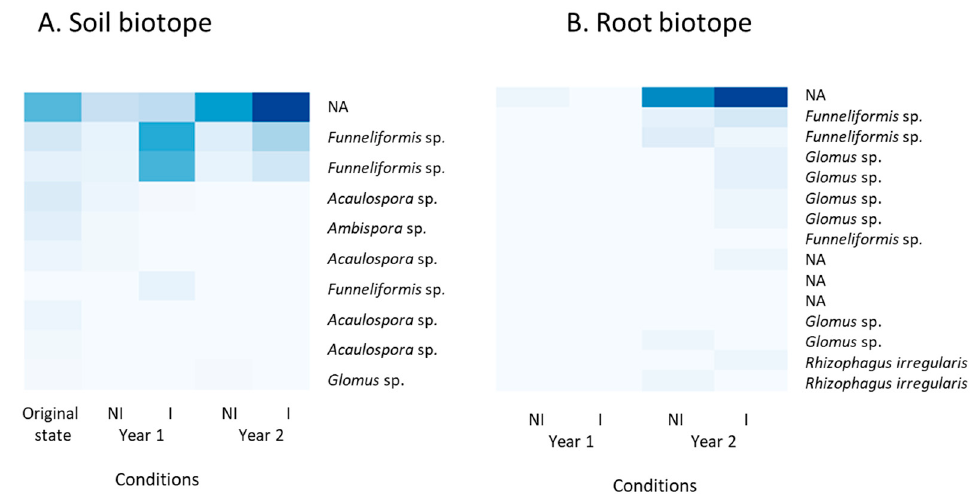
Figure 4. Heatmap representation based on the abundance of the 10 and 15 most-represented ASVs from the 18S rRNA gene data set identified in the rhizospheric soil ( A ) and root ( B ) biotopes, respectively. NI: non-inoculated; I: inoculated; NA: non-assigned.